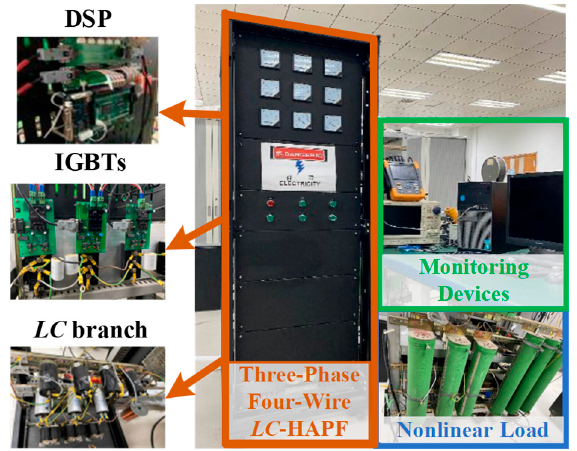
Figure 7. Experimental prototype of 110 V–5 kVA LC -HAPF.